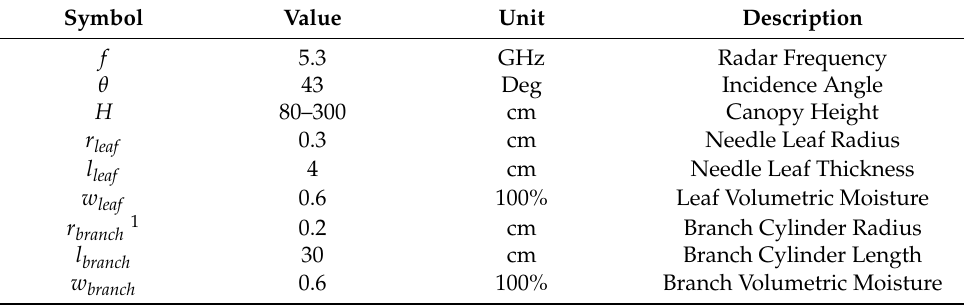
Table 2. Input parameters of canopy